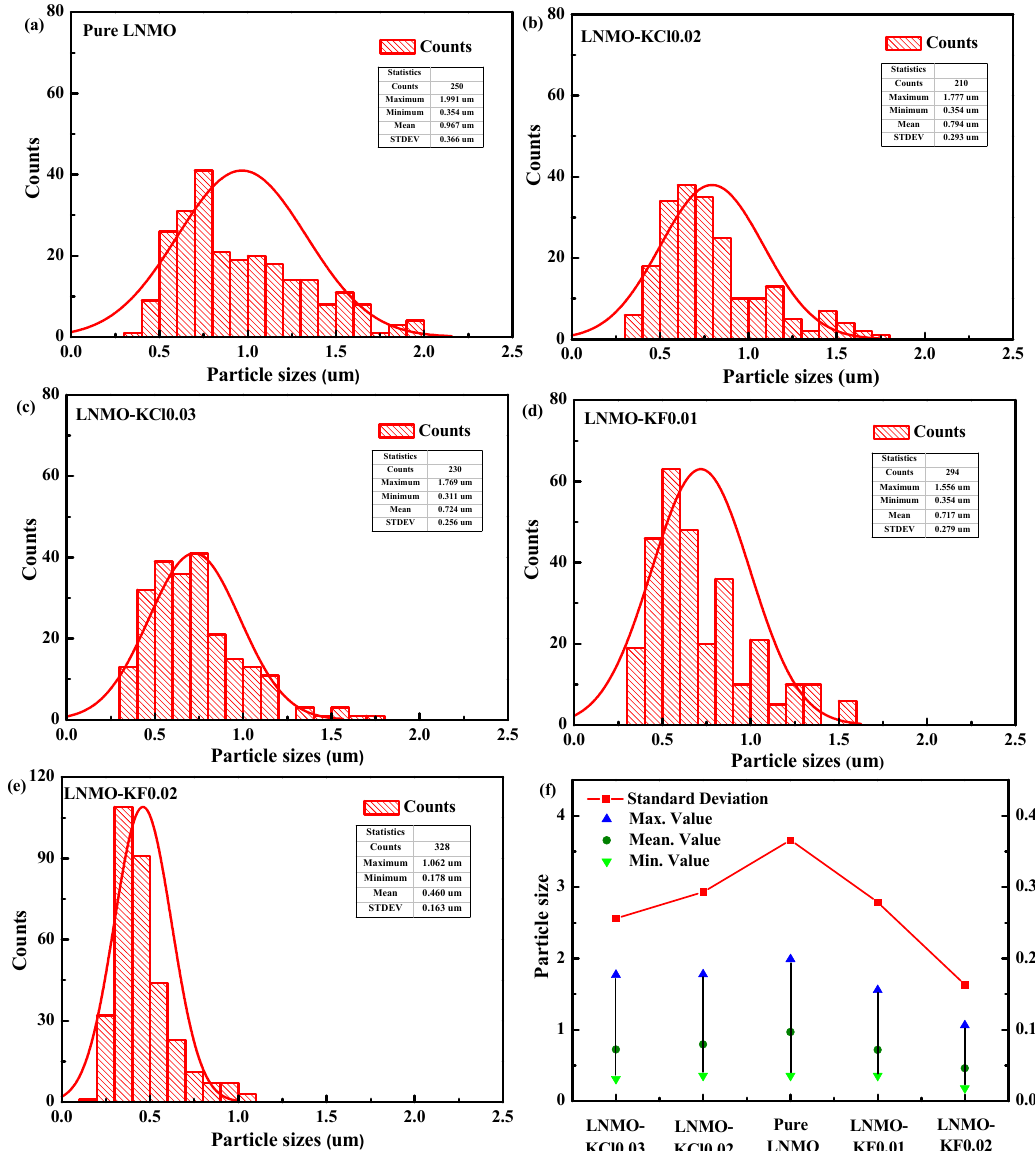
Figure 5. Particle size distributions of pure LNMO ( a ), LNMO-KCl0.02 ( b ), LNMO-KCl0.03 ( c ), LNMO-KF0.01 ( d ), and LNMO-KF0.02 ( e ); The standard deviations for the five samples ( f ).